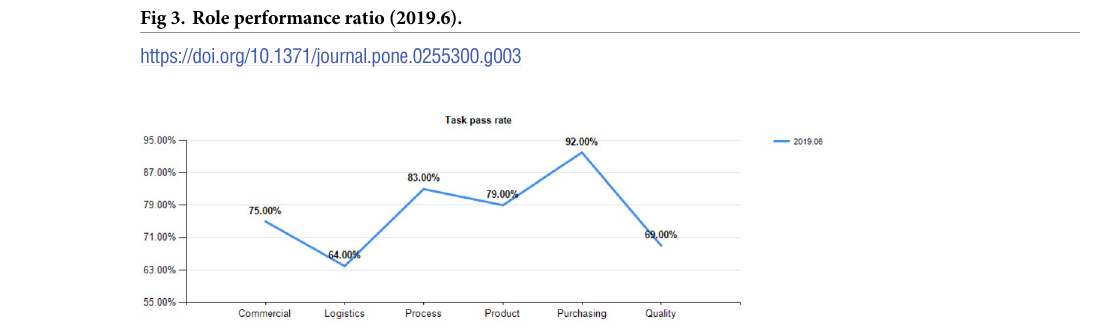
Fig 4. Closure rate of post functional tasks (2019.6).